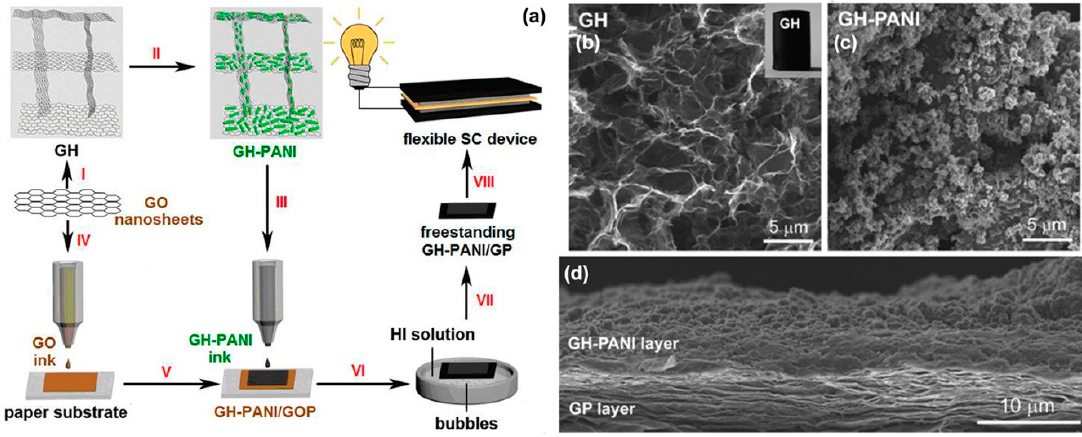
Figure 12. ( a ) Schematic illustration of the fabrication process of GH PANI/GP; SEM images of GH ( b ); GH-PANI ( c ); GH-PANI/GP ( d ). Reproduced with permission from [133]. American Chemical Society (2014).